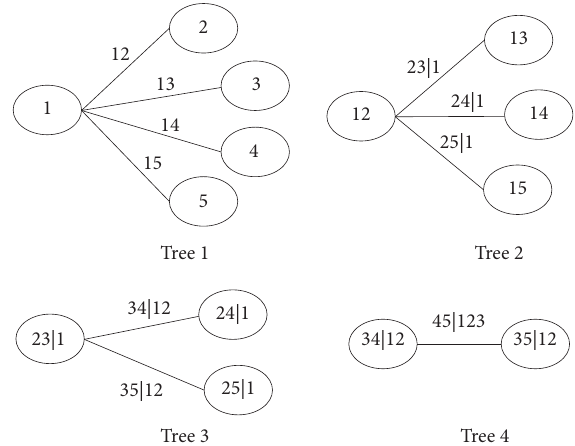
Figure 1: Five-dimensional C-vine structure.